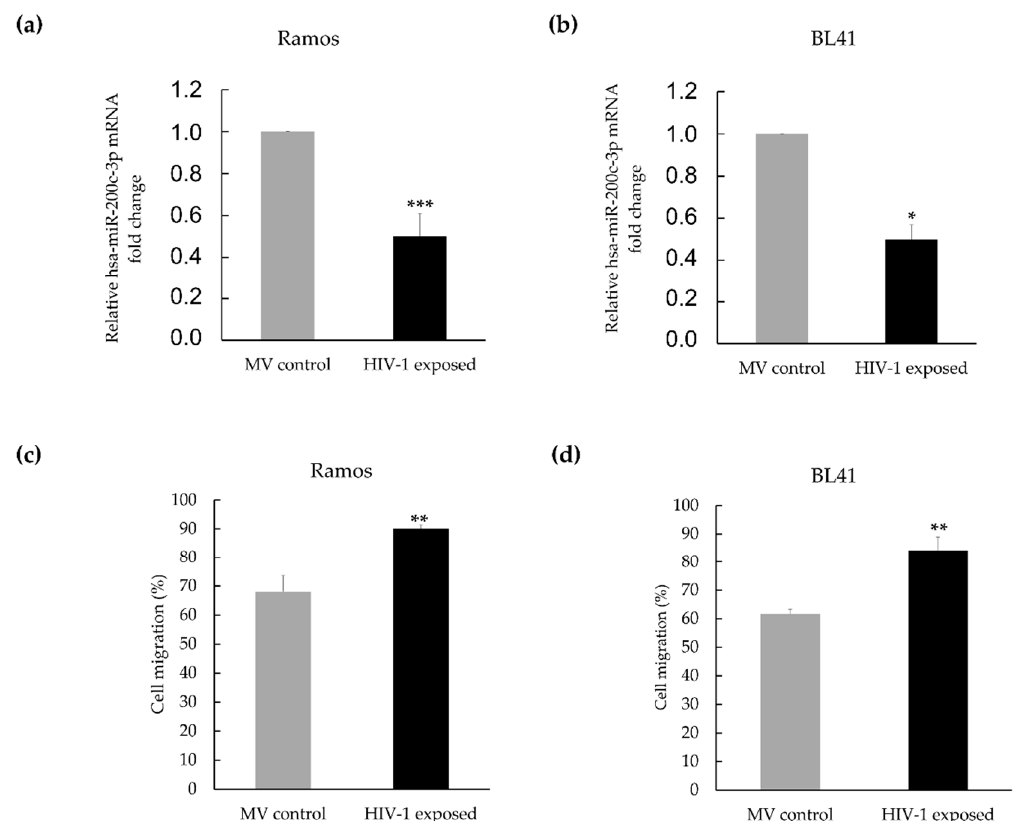
Figure 3. The downregulation of hsa-miR-200c-3p in HIV-1 AT-2 treated cells correlates with enhanced cell migration. ( a )